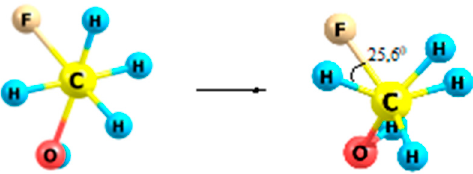
Figure 17. Conformers of S-1-fluoroethanol. Adapted with modification [257].